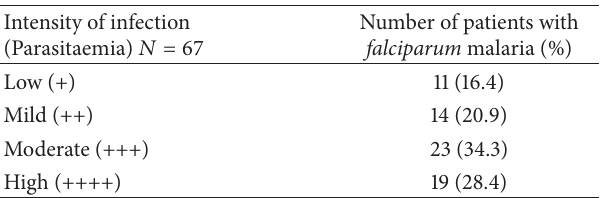
Table 1: Occurrence of P. falciparum malaria in parasitaemia patients by intensity of